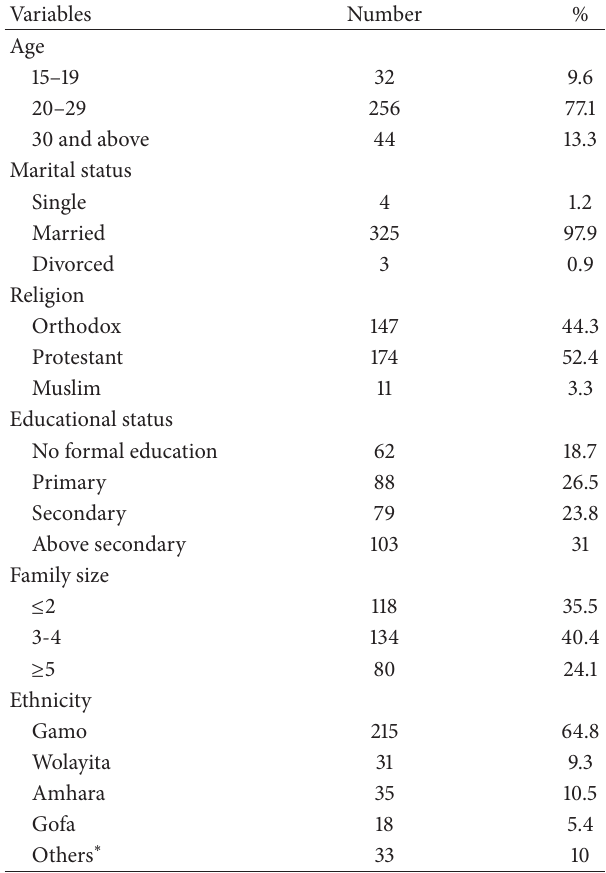
Table 1: Sociodemographic characteristics of ANC attendees